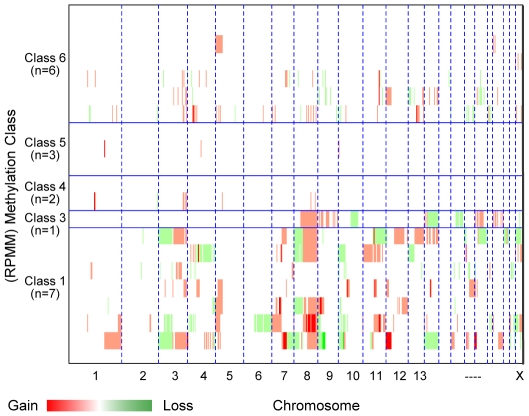
Copy number plots by RPMM class.Copy number data for 19 tumors are coordinately arranged by chromosome and grouped together according to RPMM-modeled methylation classes. The total number of methylation classes is reduced from the original six [20] to five in this study because membership in Class 2 methylation profile is not represented in the subset of 19 tumors investigated.